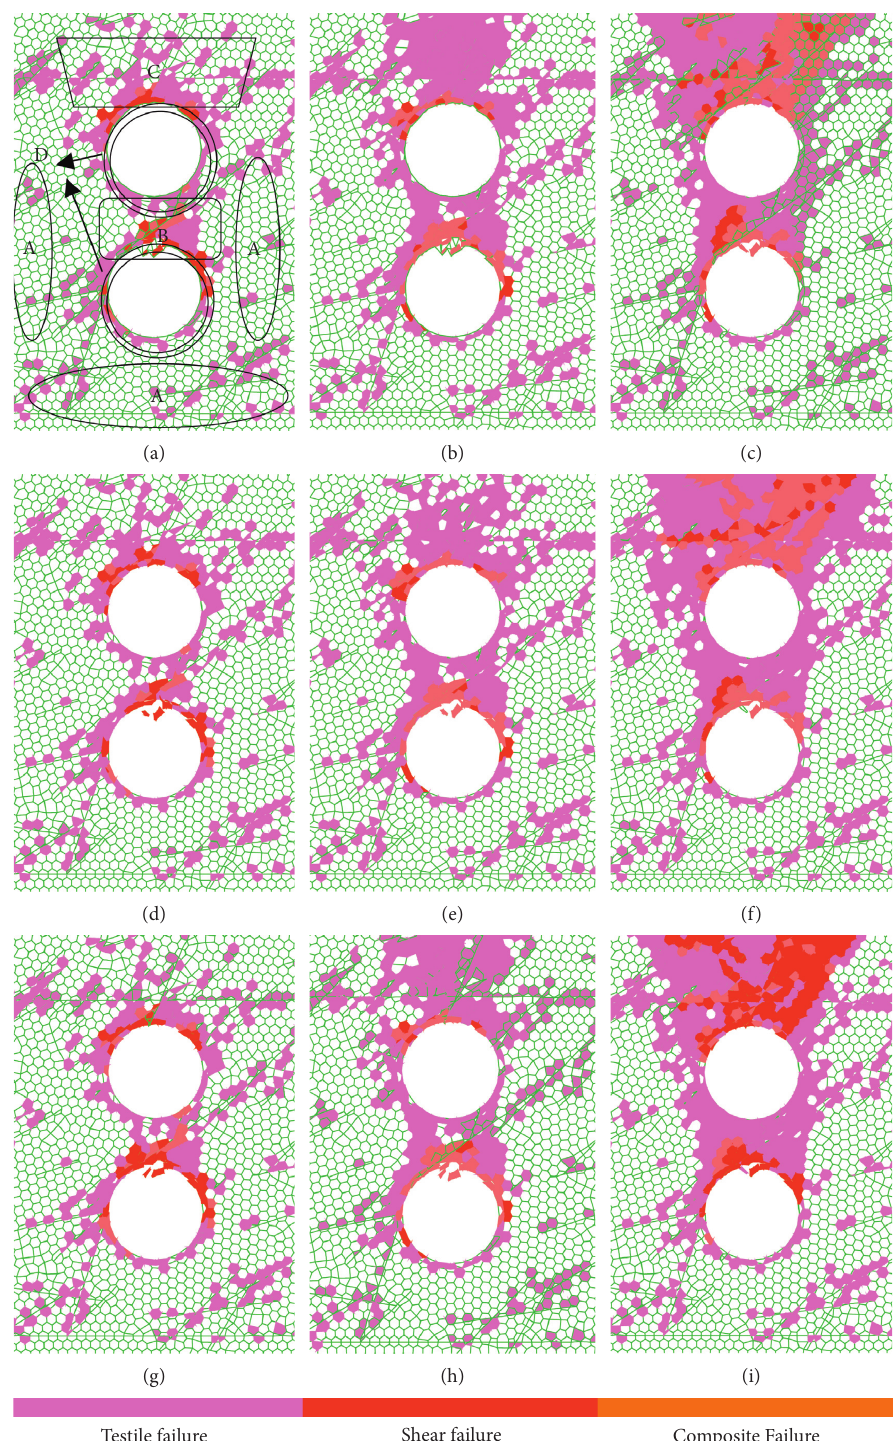
Figure 7: Failure morphology of surrounding